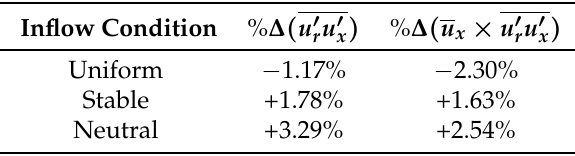
Table 2. Percent change (DRWT-SRWT) in cumulative streamwise momentum and kinetic energy for the three inflow